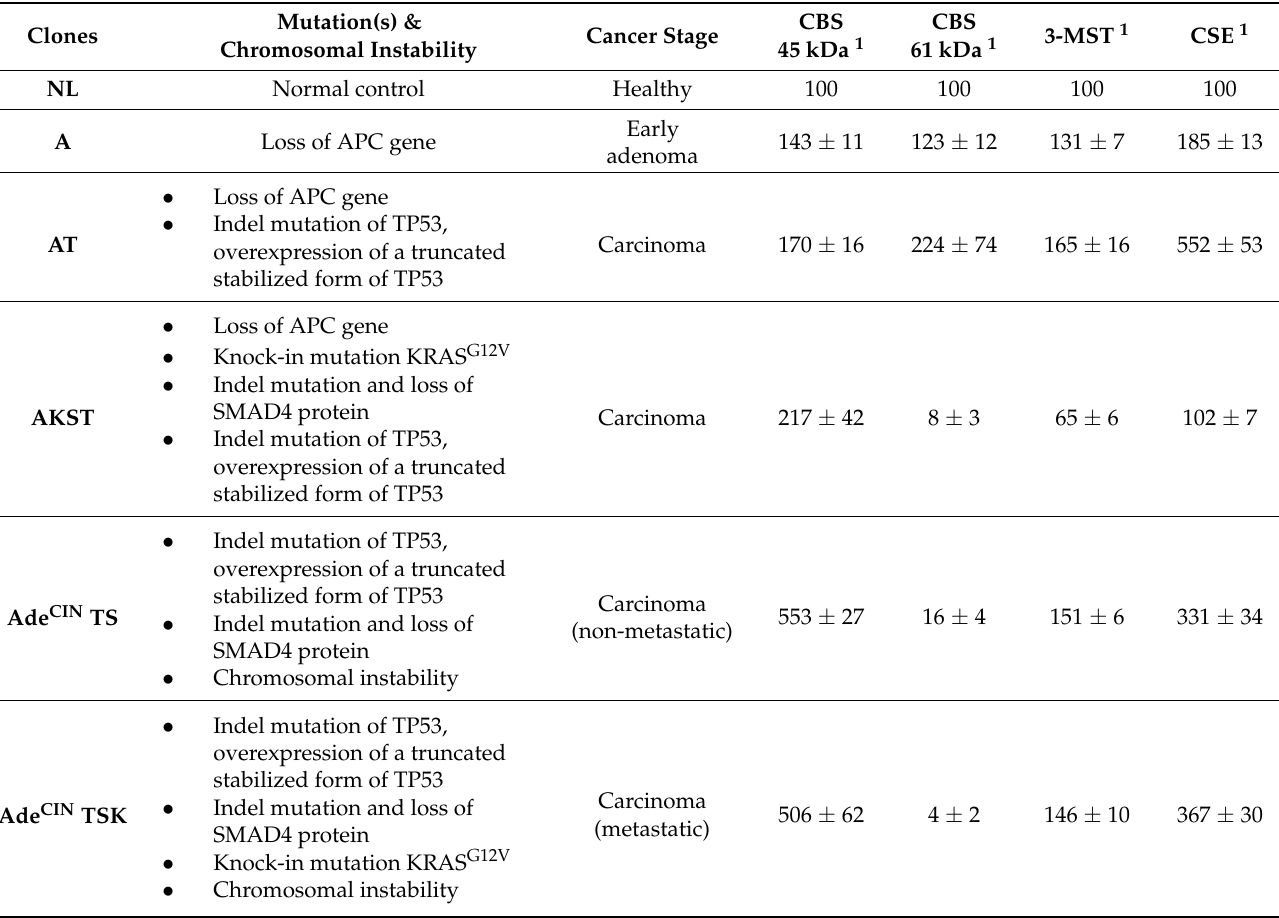
Table 1. Clones, associated mutations, and resultant changes in the expression (protein levels, determined by Western blotting) of H 2 S-producing